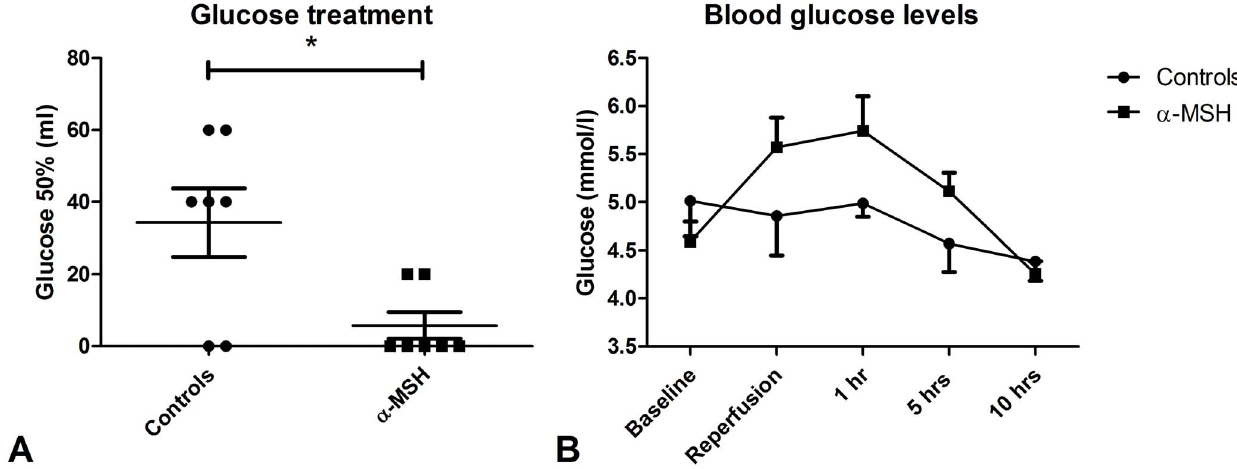
Figure 6. Effect of a -MSH on glucose levels. a -MSH significantly reduced the need of glucose treatment (Figure 6A; *=p , 0.05) and tended to prevent a decrease of blood glucose levels (Figure